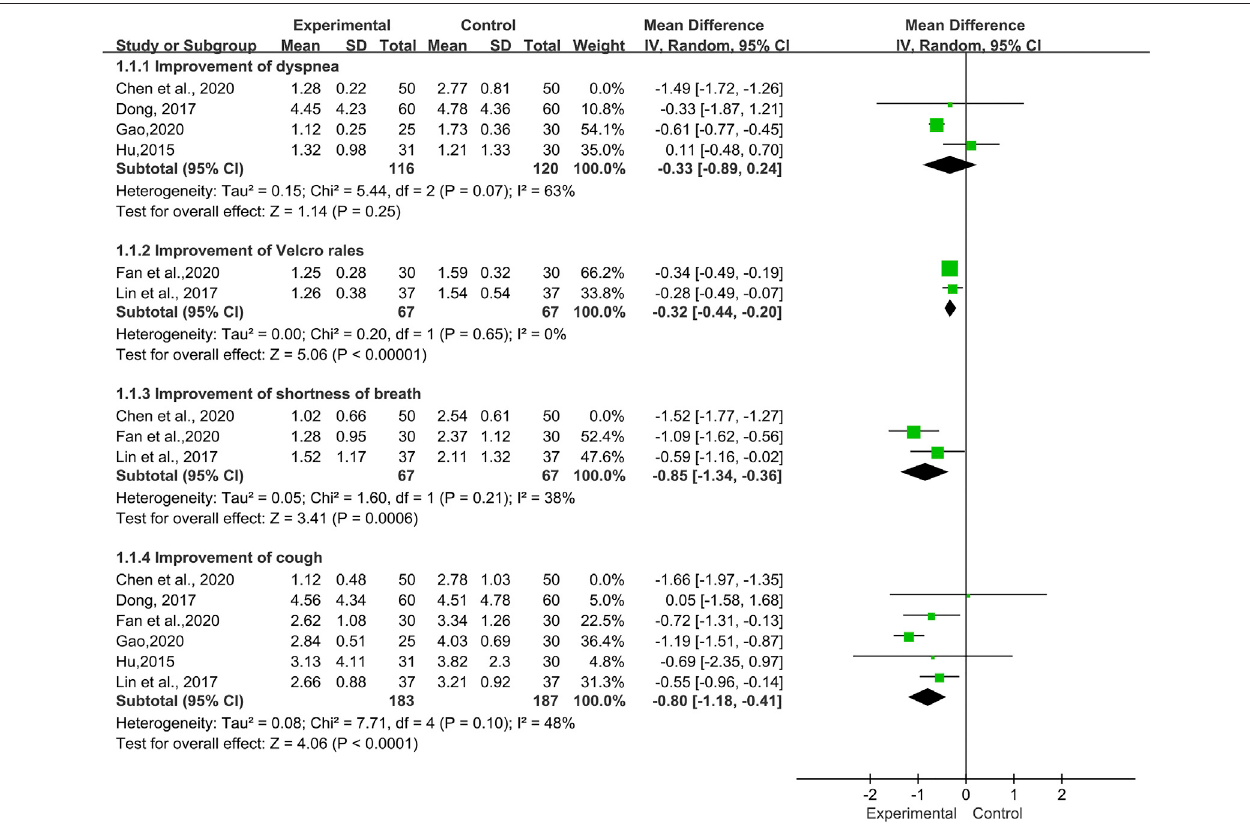
FIGURE 10 | Forest plot of sensitivity analysis of symptoms and signs improvement with TwHF combined with conventional treatment versus pure conventional treatment.